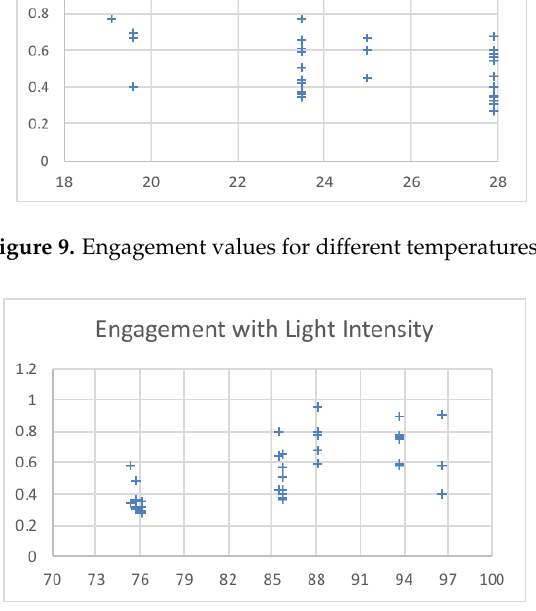
Figure 10. Engagement values for different light intensity values.